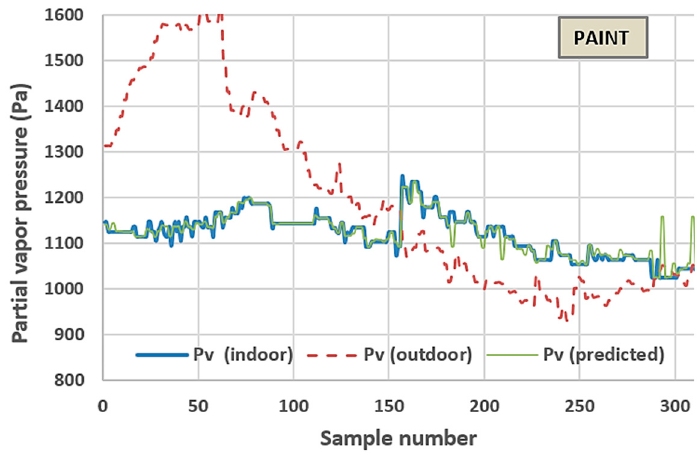
Figure 5. Partial vapour in office buildings with paint as an internal covering material.